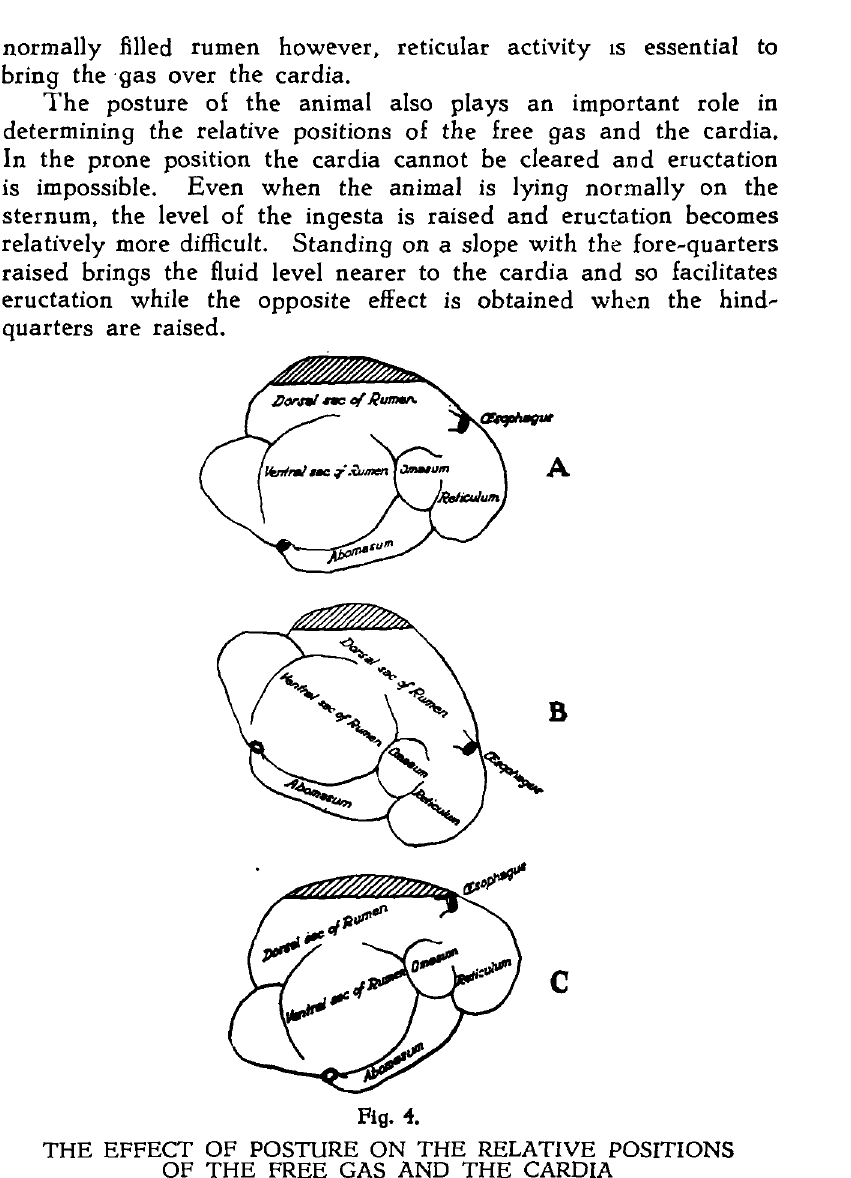
A. Animal on level ground. B. Facing